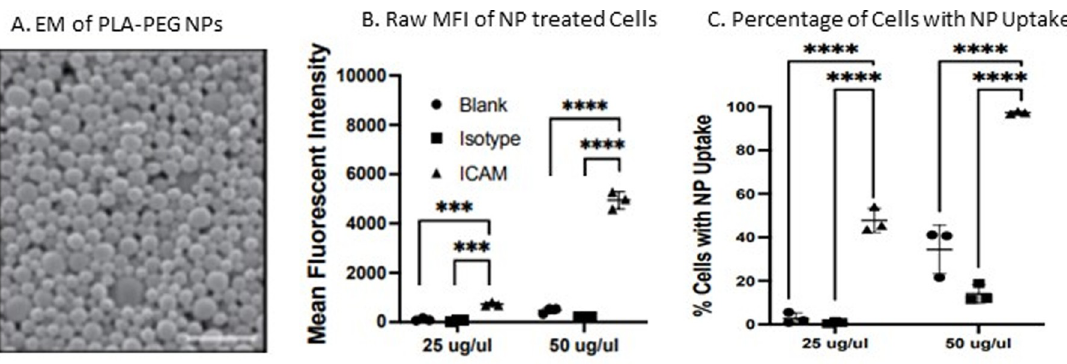
Fig 3. Nanoparticles synthesis with surface conjugation to antibody improves uptake in CFBE cells in vitro. A) By SEM, PLA-PEG particles are uniform in size (Bar = 1 μ m). B&C) Flow cytometry of CFBE Cells treated with green (DiO) dye. These NPs were either, blank unconjugated, isotype conjugated or ICAM antibody conjugated. B MFI of treated cells and C) percentage cells with NP internalization were measured. (n = 3 for each treatment) ( ��� p < 0.001 & ���� p <